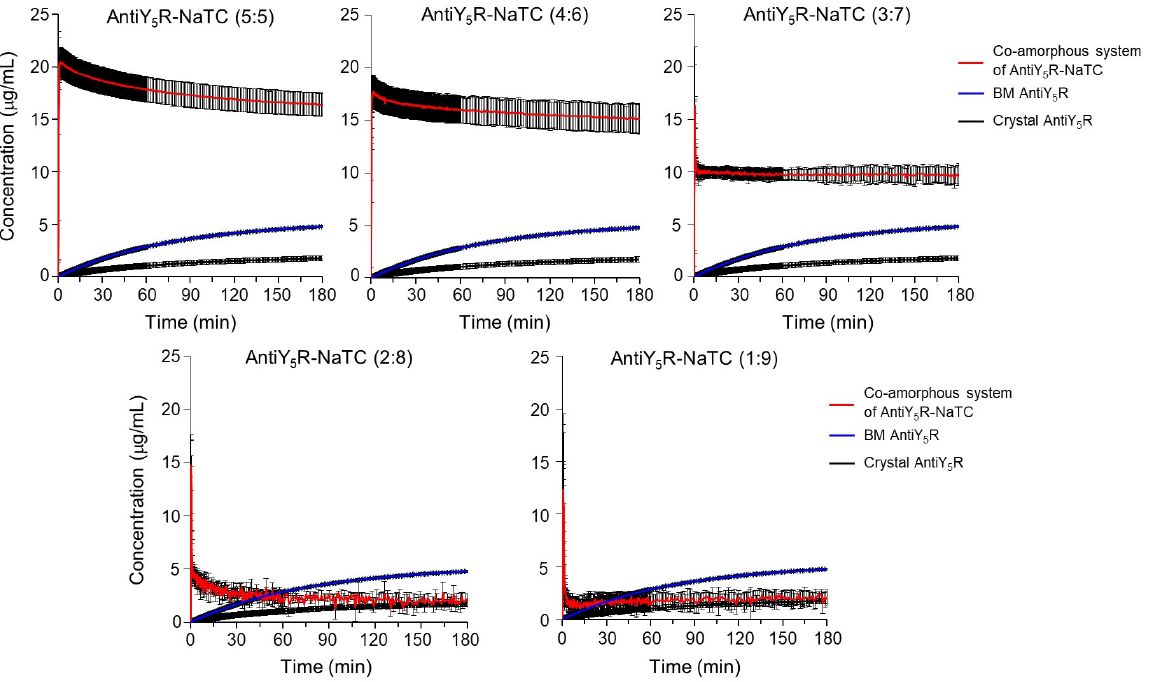
Figure 8. Powder dissolution profiles of crystalline AntiY 5 R, AntiY 5 R prepared by ball milling method (BM), co-amorphous systems from AntiY 5 R-NaTC (5:5) to AntiY 5 R-NaTC (1:9) prepared by BM. Results were expressed as the mean with standard deviation of three experiments. Keys: Red, blue and black solid line indicates the dissolution profile of the co-amorphous system, ball-milled AntiY 5 R and crystalline AntiY 5 R, respectively. Table 3. Dissolution concentrations of AntiY 5 R from its crystalline, ball-milled AntiY 5 R and co-